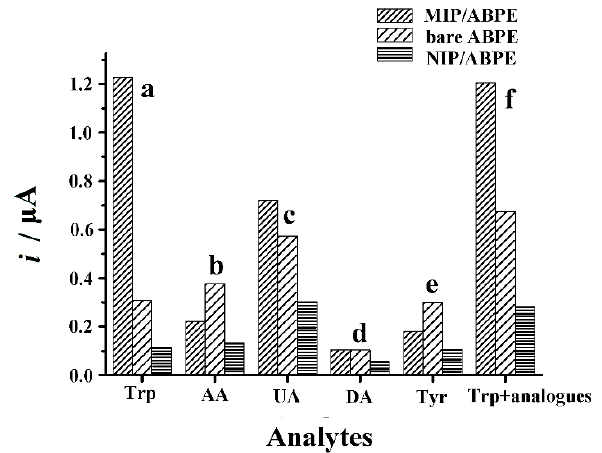
Figure 8. The selectivity of the MIP / ABPE: (a) 50 µ M Trp; (b) 1 mM ascorbic acid (AA); (c) 1 mM uric acid (UA); (d) 1 mM dopamine (DA); (e) 1 mM tyrosine (Tyr); (f) 50 µ M Trp mixed with 5 kinds of analogues (50 µ M Trp + 1.0 mM AA + 1.0 mM UA + 1.0 mM DA + 1.0 mM Tyr). Supporting electrolyte: